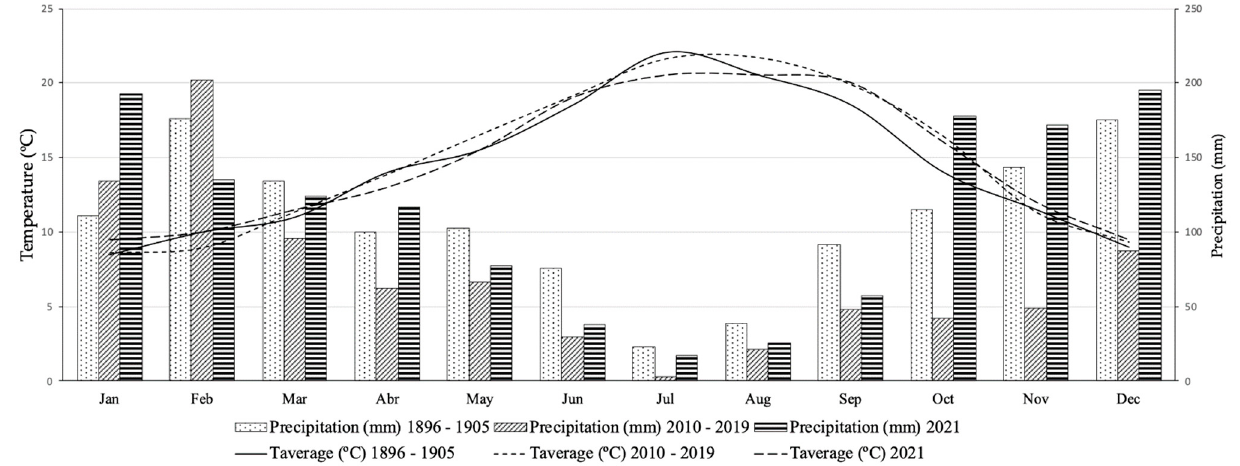
Figure 7. Comparison between the results obtained by J. Kempf for the decade 1896–1905, the results obtained through the METEOBLUE platform for the decade 2010–2019 with the data available in the SNIRH website (available in https://snirh.apambiente.pt, accessed on 30 June 2021) for the meteorological station of MOREIRA DO REI (05I/04G), located in the municipality of Fafe (distancing approximately 15 km from the Guimarães city center), and the modelled data for the year 2021 with the results obtained on the METEOBLUE platform.